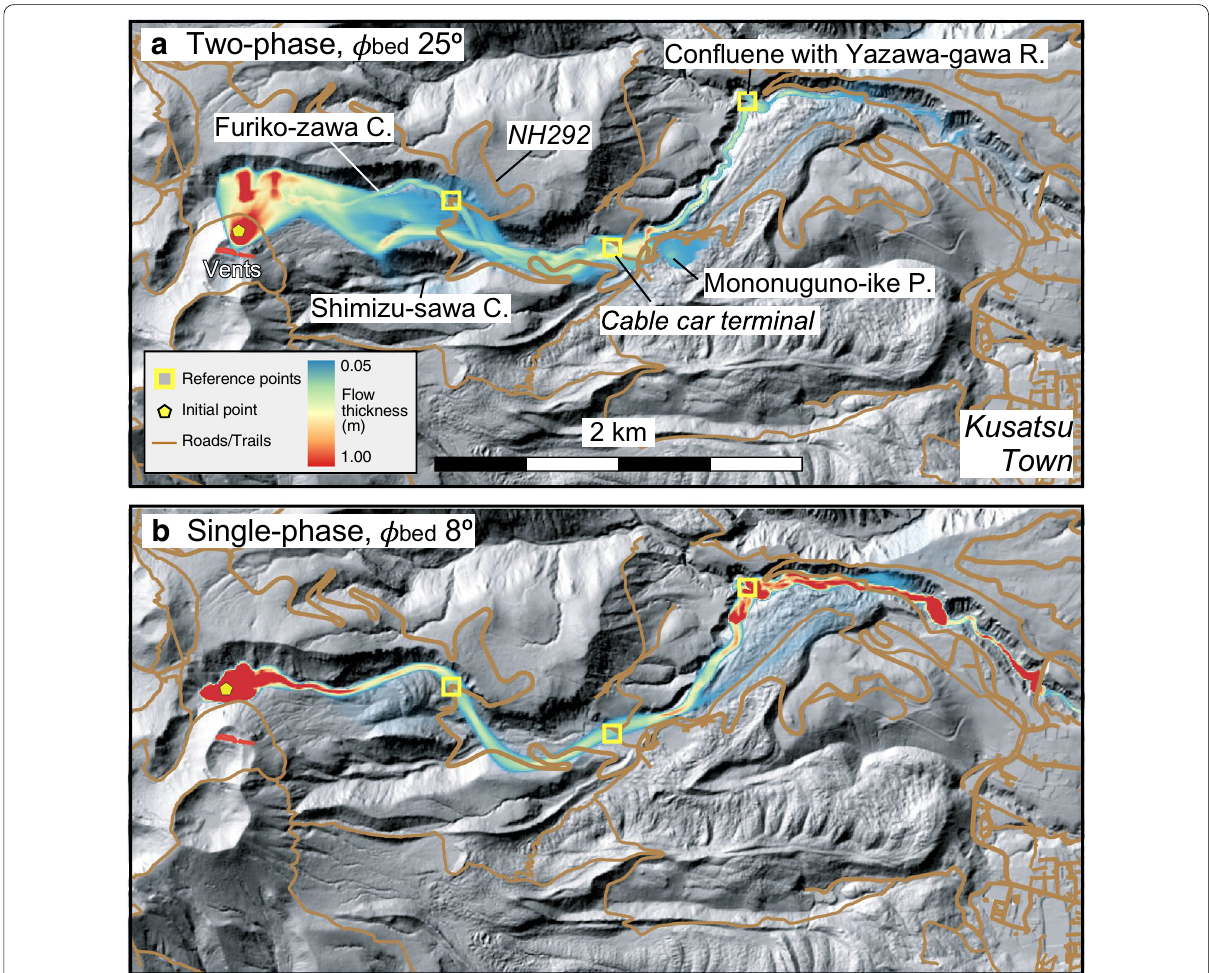
Fig. 13 Simulated flow distribution of the Scenario C (full snowmelt): a two-phase with the bed friction angle of 25° and b single-phase with the bed friction angle of